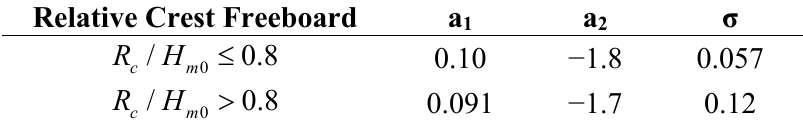
Table 1. Values of the coefficients and reliability of Equation